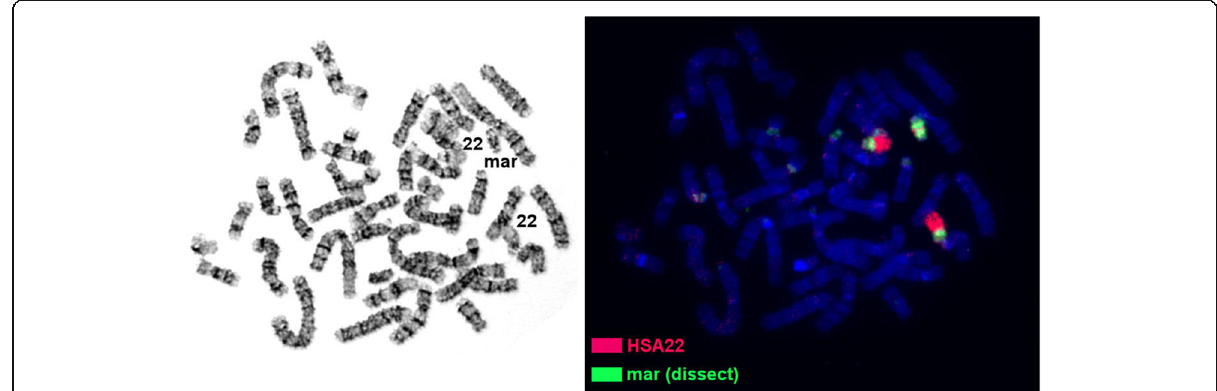
Fig. 1 FISH with painting probes of human chromosome 22 (red signal) and of the marker microdissected chromosome (green signal) on metaphase chromosomes of the